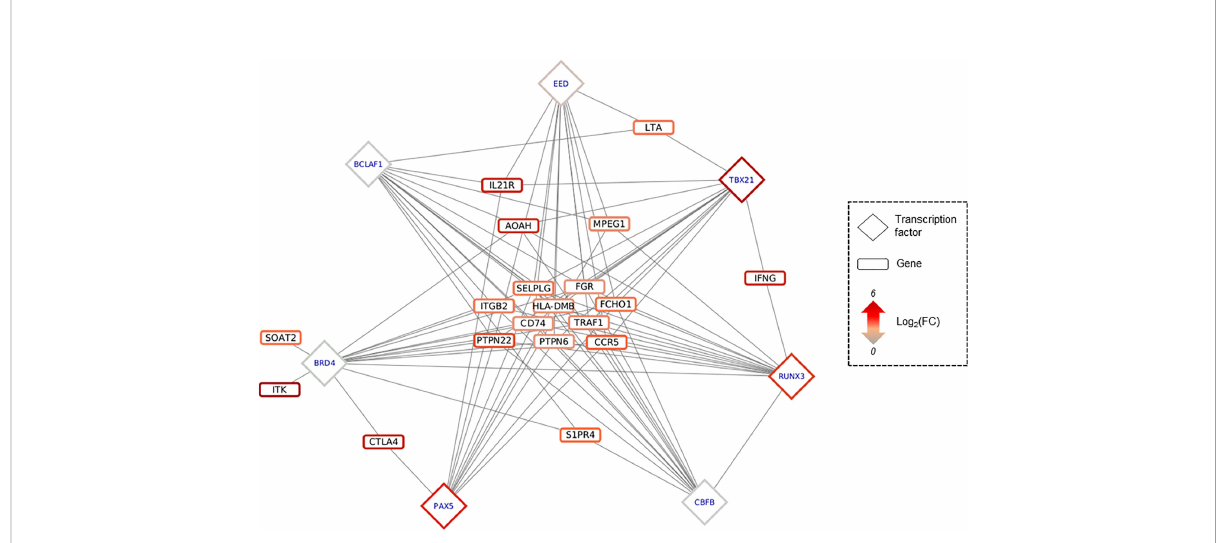
FIGURE 5 Predicted regulatory interaction in IFNy-Th1 pathway. Network composed by 19 genes involved in IFNy-Th1 pathway, and the top 7 TF predicted as targeting those 19 genes, according to OLOGRAM based on ReMap database. TF are written in blue in diamond, and genes in black in rectangle. Shapes borders are colored according to the fold change, from green to red.